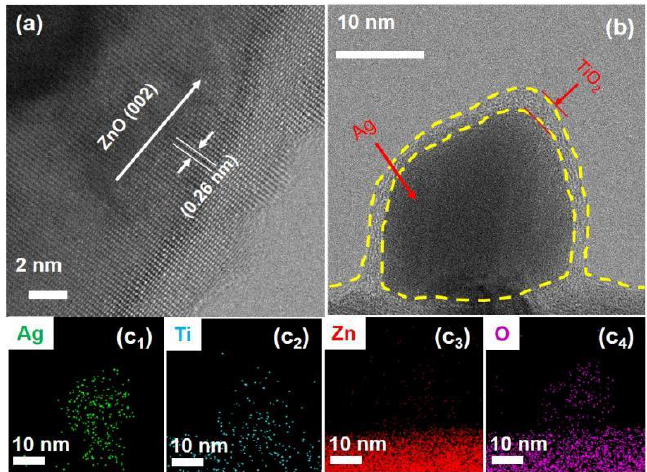
Figure 4. STEM image focus on ( a ) exposed ZnO nanorod core and ( b ) Ag NP at ZnO/TiO 2 interface; EDS mappings of ( c 1 ) Ag, ( c 2 ) Ti, ( c 3 ) Zn, and ( c 4 ) O.